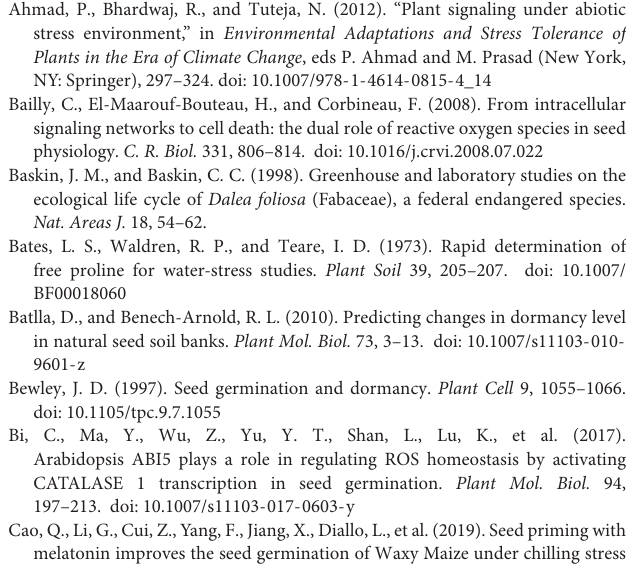
Supplementary Table 9 | Two-way ANOVA test for the OsCAT5 expression